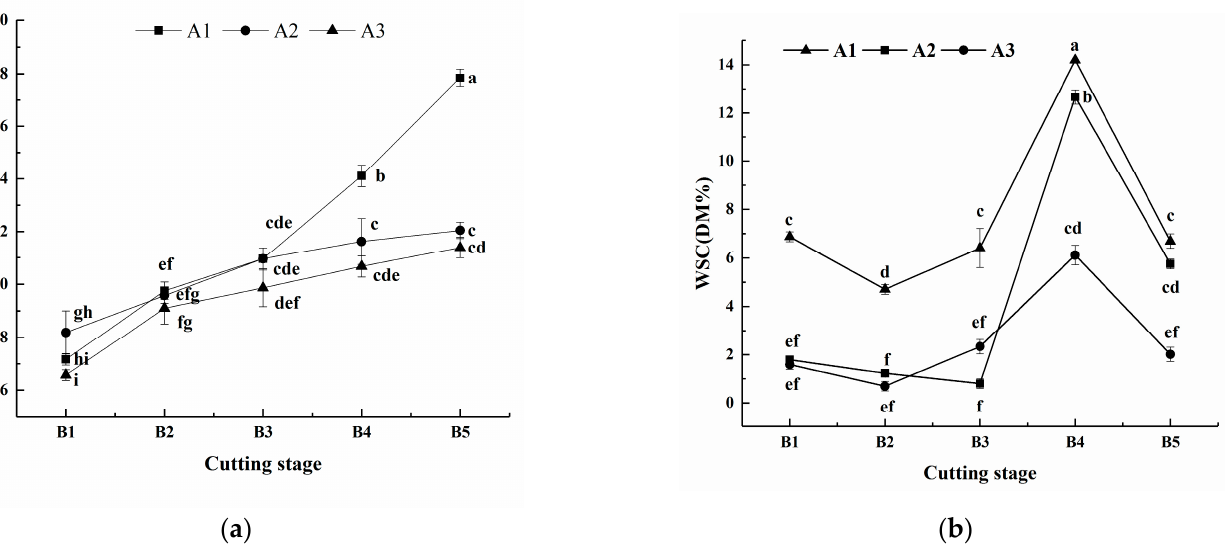
Figure 1. The dry matter yield (DMY) ( a ) and average WSC content ( b ) of three forages at different cutting stages. Different letters in each figure mean significantly differences at p < 0.05. A1: triticale; A2: rye; A3: oat; B1: heading stage; B2: flowering stage; B3: grouting stage; B4: milky stage; B5: dough stage.